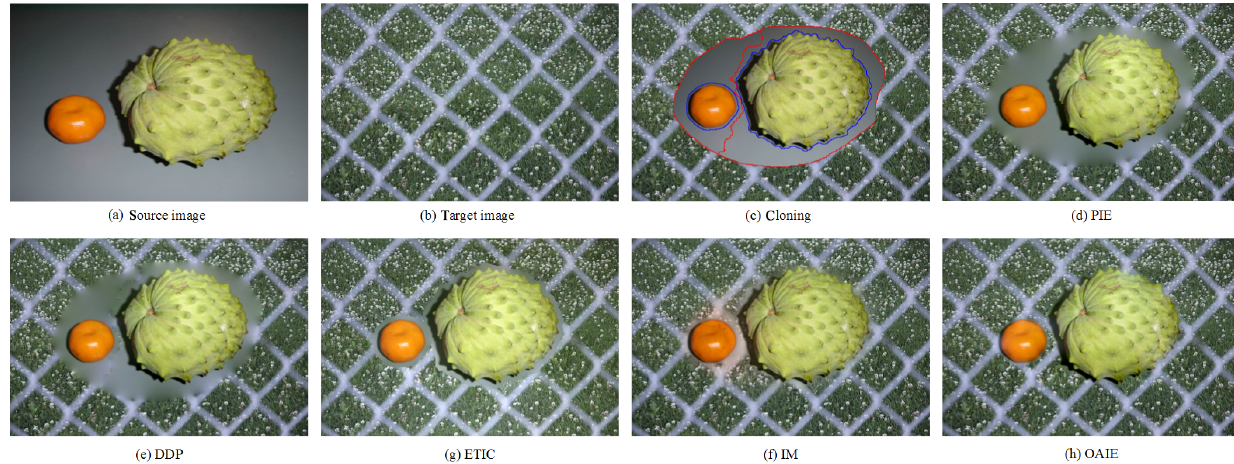
Fig. 3 Seamless cloning when combining images with larges differences in texture. OAIE obtains consistent local structures and global textures while none of the other methods preserve texture consistency well (leading to unnatural colors or textures).